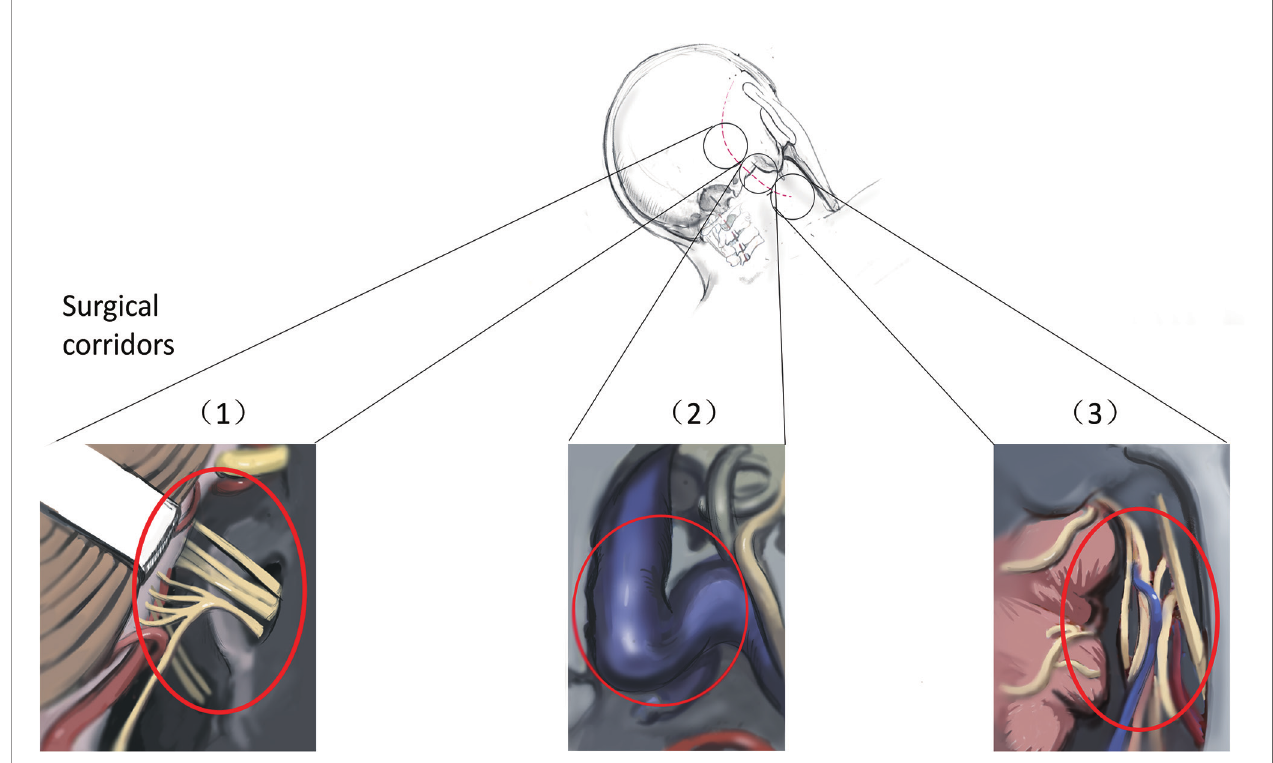
FIGURE 1 | Three surgical corridors of suboccipital paracondylar-lateral cervical approach. (1) The suboccipital retrosigmoid corridor exposes the cerebellopontine angle cistern and cerebellomedullary angle cistern; (2) The paracondylar corridor exposes the jugular foramen; (3) The lateral cervical corridor exposes the retrostyloid region of parapharyngeal